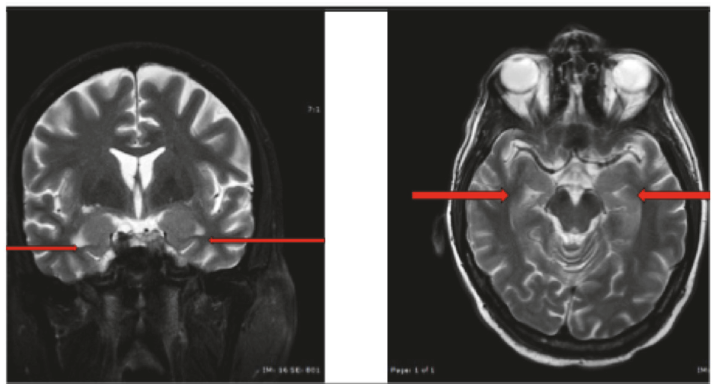
Figure 1: MRI brain demonstrating bilateral mesial temporal lobe hyperintensities (red arrows), right greater than left, without volume loss: (left panel) T2-weighted Coronal section; (right panel) T2-weighted with FLAIR axial